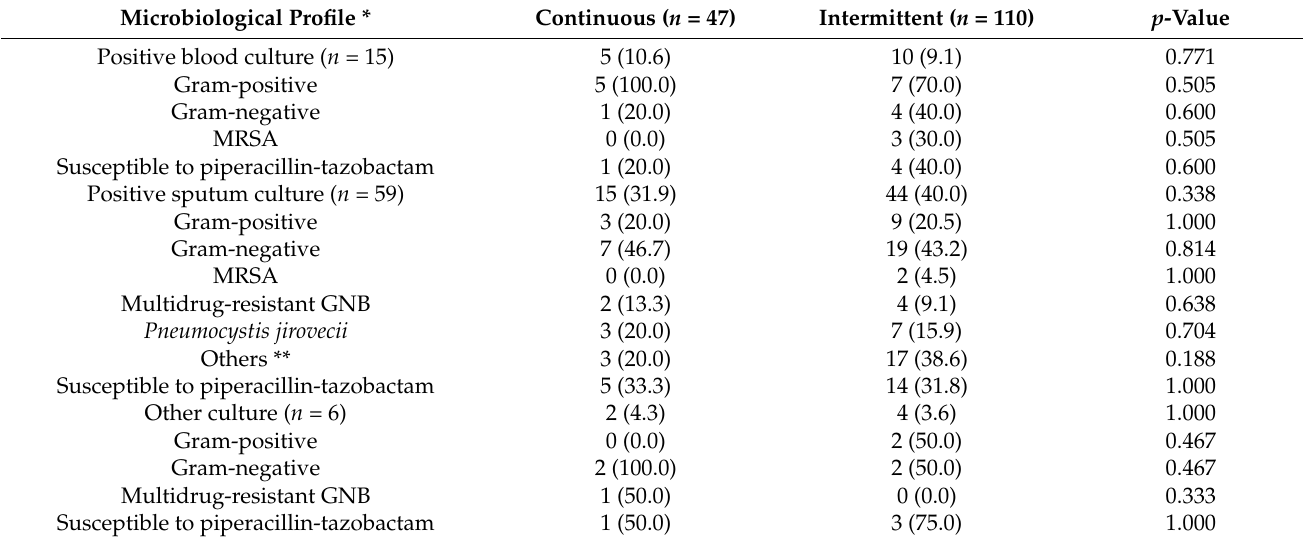
Table 2. Microbiological profile of patients by the type of administration of